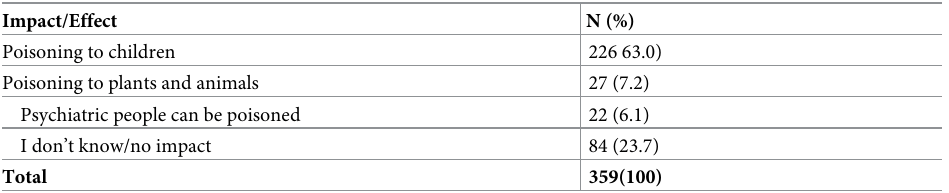
Table 4. Household member’s knowledge on the impact of improper